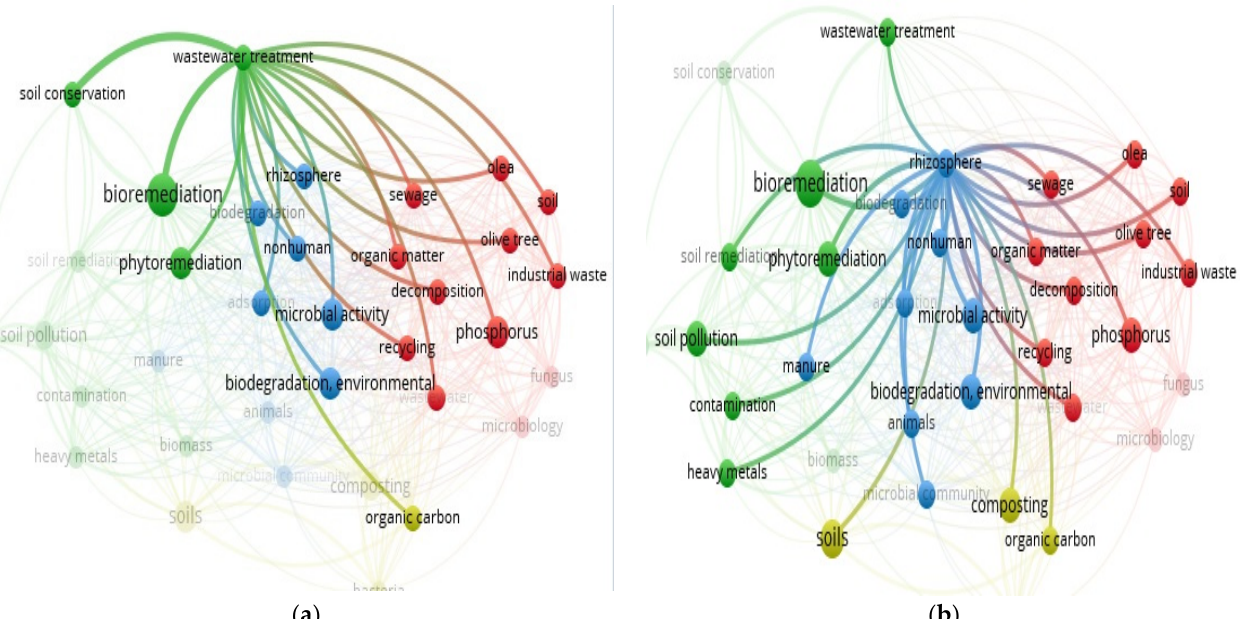
Figure 14. Analyzing Scopus results with the VOSviewer. The wastewater treatment ( a ) and rhizo- sphere ( b ) paradigms.